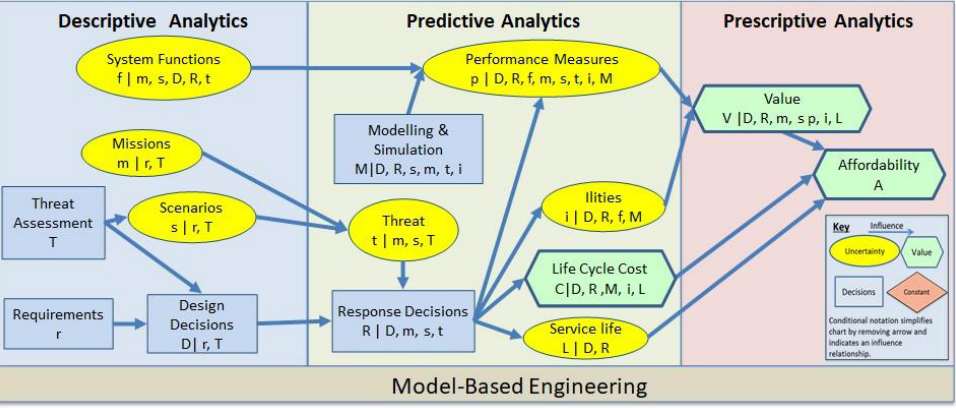
Figure 7. Integrated Trade-off Analysis Framework [40].